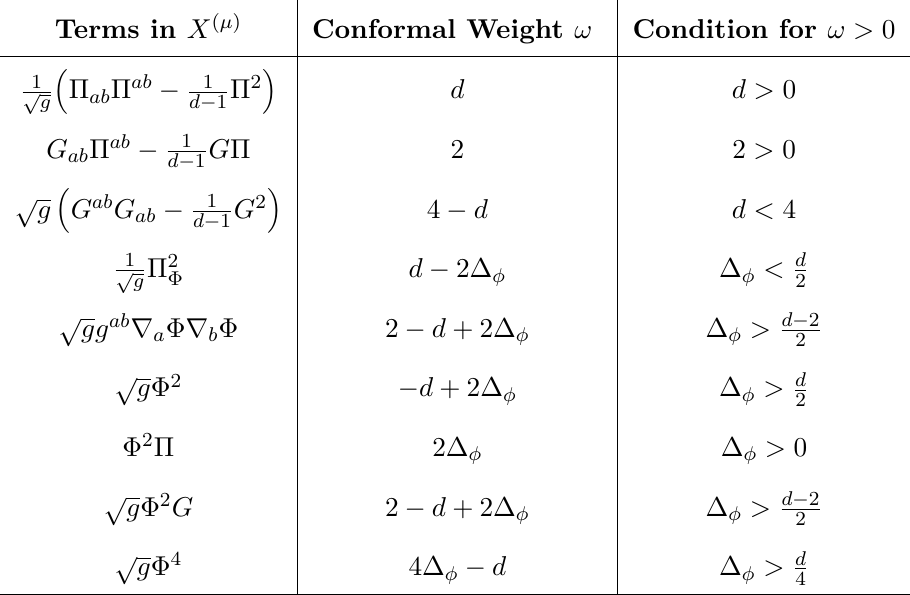
expect that the higher n-point functions of the stress-tensor will not agree with a normal semiclassical gravitational bulk with Dirichlet boundary conditions.